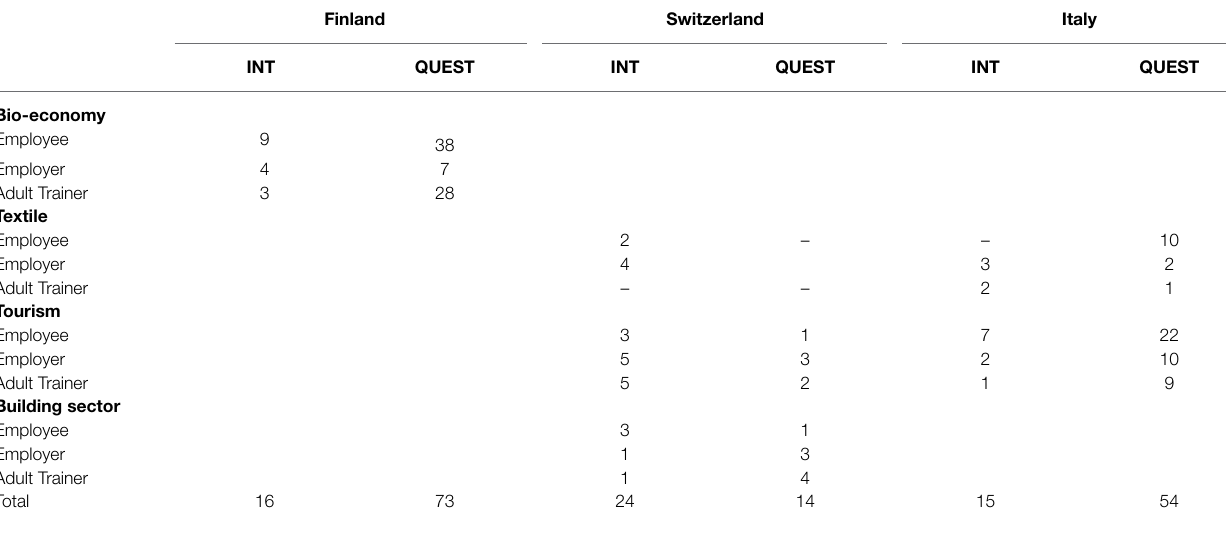
TABLE 1 | Participants in the interview (INT) and the questionnaire (QUEST)